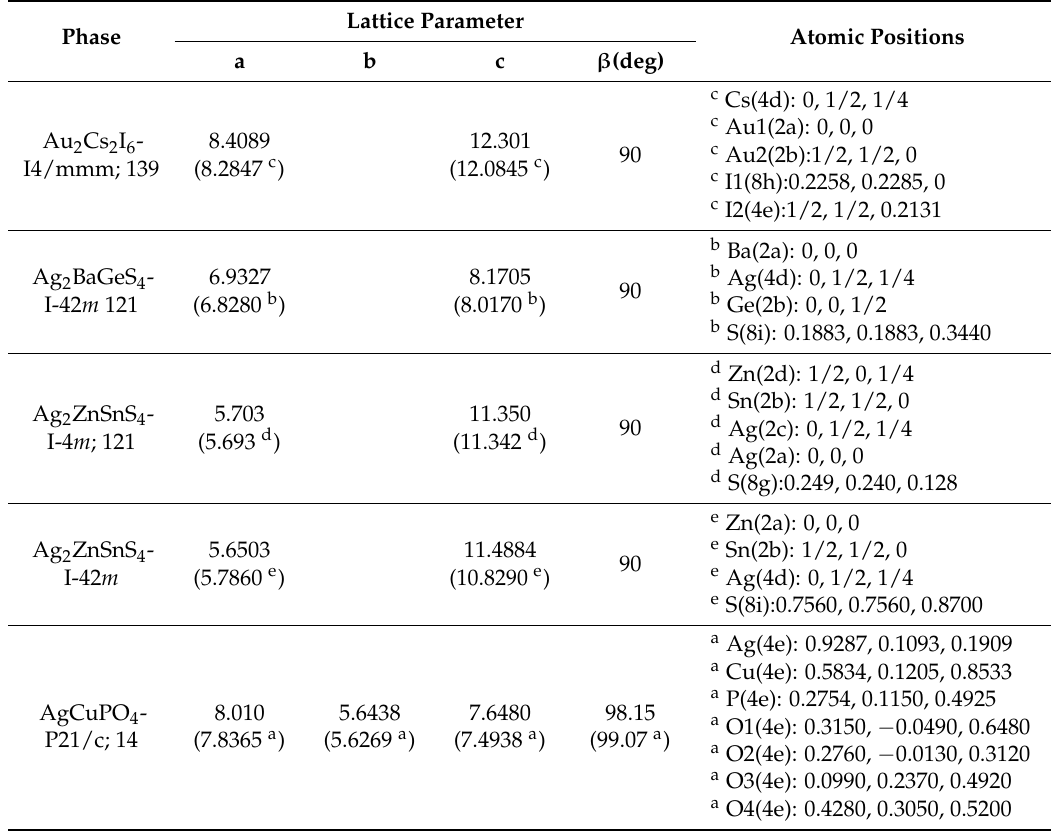
Table 1. Calculated structural parameters and atomic positions of AgCuPO 4 , Ag 2 GeBaS 4, Au 2 Cs 2 I 6, , and Ag 2 ZnSnS 4 . Lattice Phase